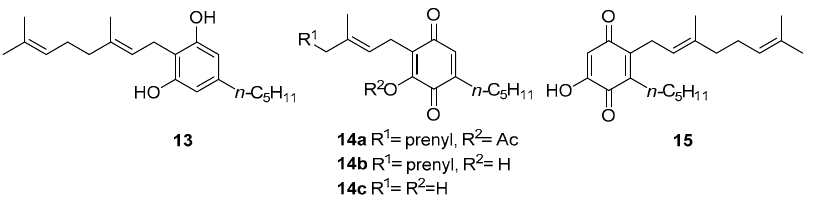
Figure 4. Structure of cannabigerol (CBG, 13 ), CBGQ-acetate ( 14a ), CBGQ ( 14b ), deprenyl-CBGQ ( 14c ) and abnormal CBGQ ( 15 ).